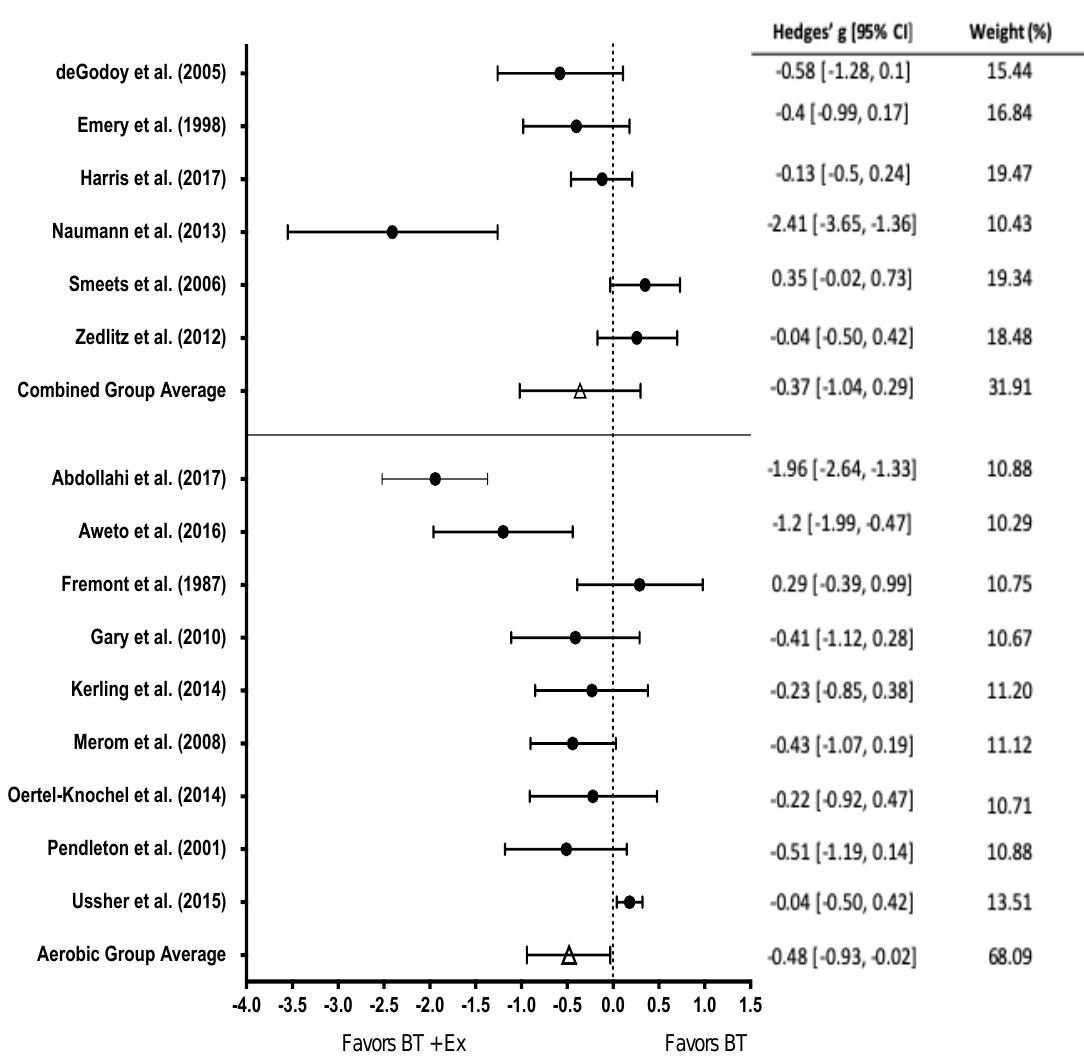
Figure 4. Subgroup analysis of combined aerobic and resistance (top) and aerobic exercise only (bottom) among studies that measured depression. Test for overall e ff ect of combined exercise g = − 0.37, p > 0.05. Test for overall e ff ect of aerobic exercise g = − 0.48, p < 0.05. BT + Ex = Behavioral Therapy + Exercise, BT = Behavioral Therapy only.